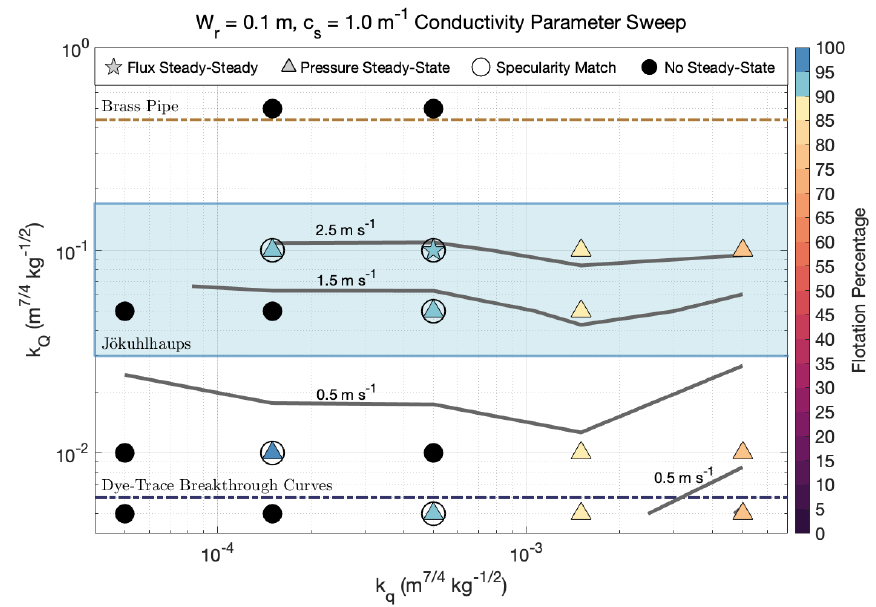
Figure A2. Same as Fig. 4 but for bed roughness parameters W r = 0 . 1m and c s = 1 . 0m − 1 .